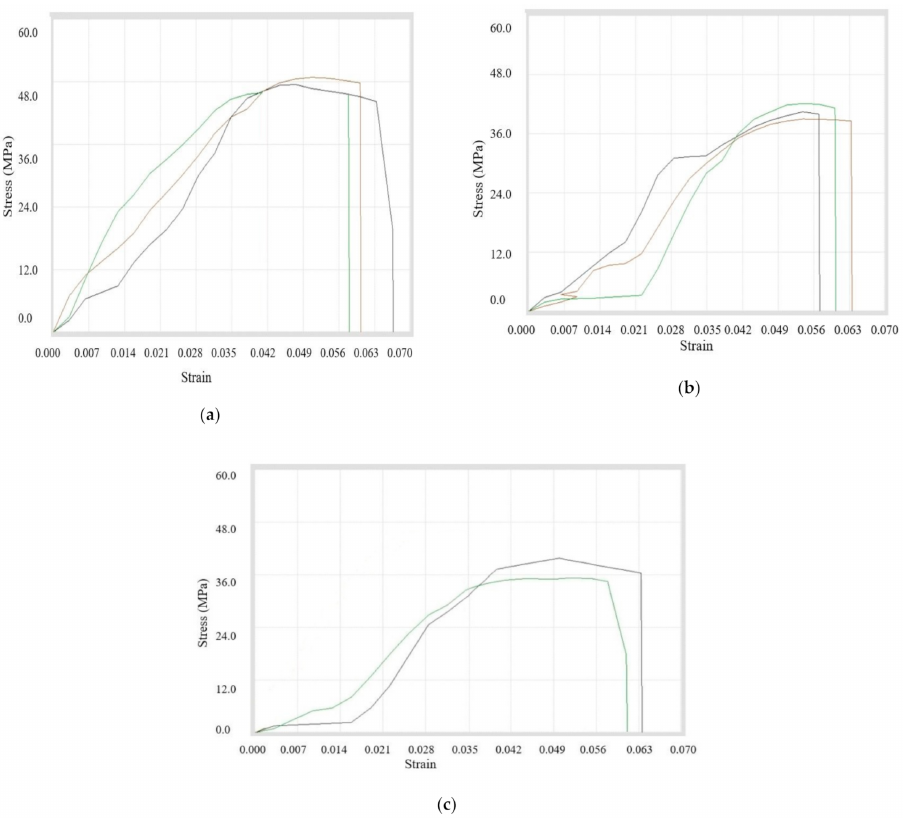
Figure 14. Stress–strain curves for ( a ) (A + B + C)4 , ( b ) (A + B + C)9 , and ( c ) (A + B + C)10 filament